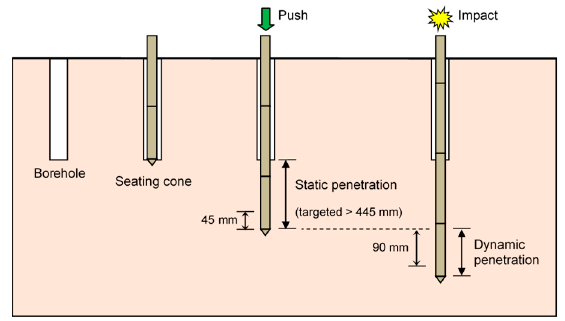
Figure 3. Procedure for a static–dynamic cone penetration tests using ICP at a depth.